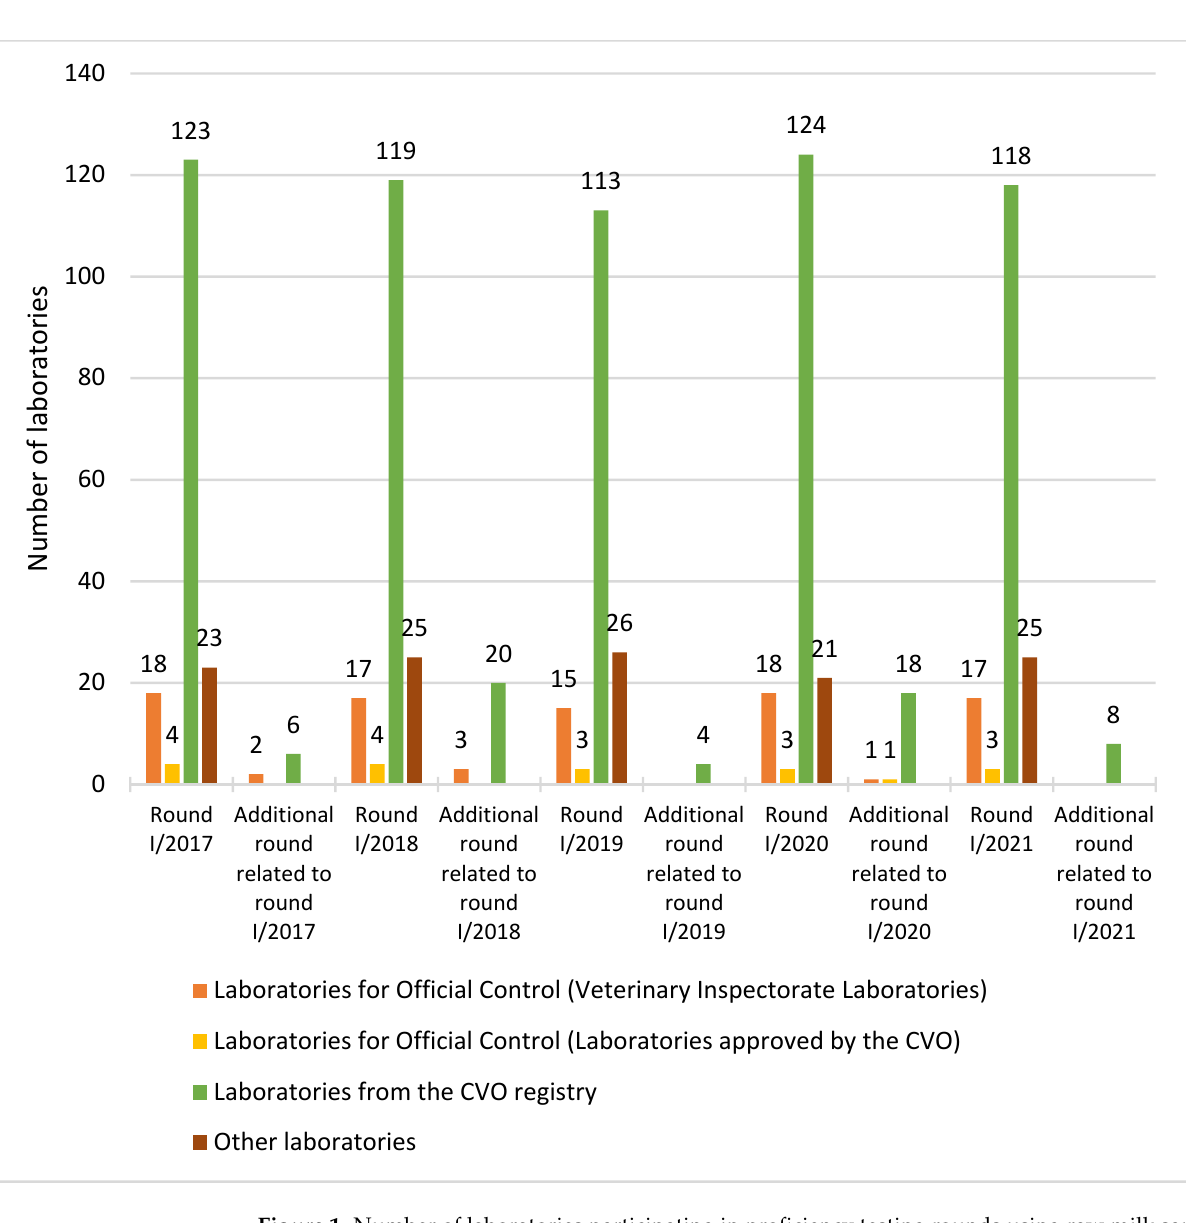
Figure 1. Number of laboratories participating in proficiency testing rounds using raw milk samples in 2017–2021. CVO—Chief Veterinary Officer.